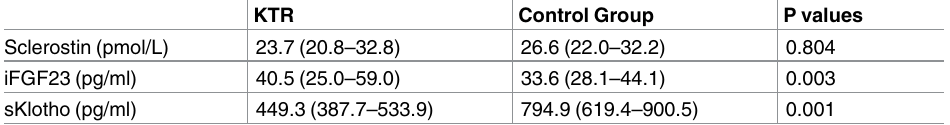
Table 2. Serum levels of Sclerostin, FGF23 and Klotho in our control group and renal transplant population. KTR Control Group P